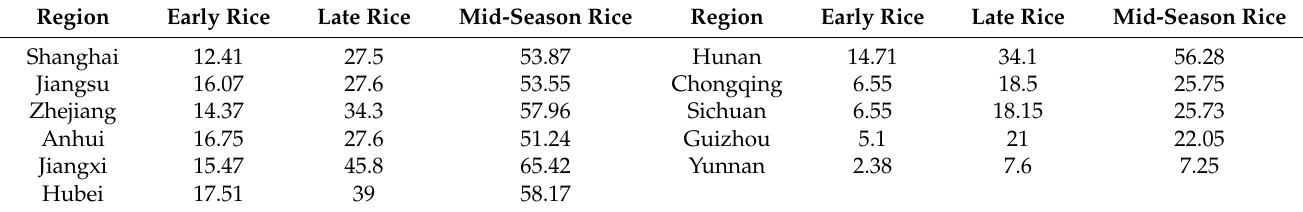
Table 2. The CH 4 emission coefficient of rice during its growth cycle in different regions of Yangtze River economic belt (g/m 2